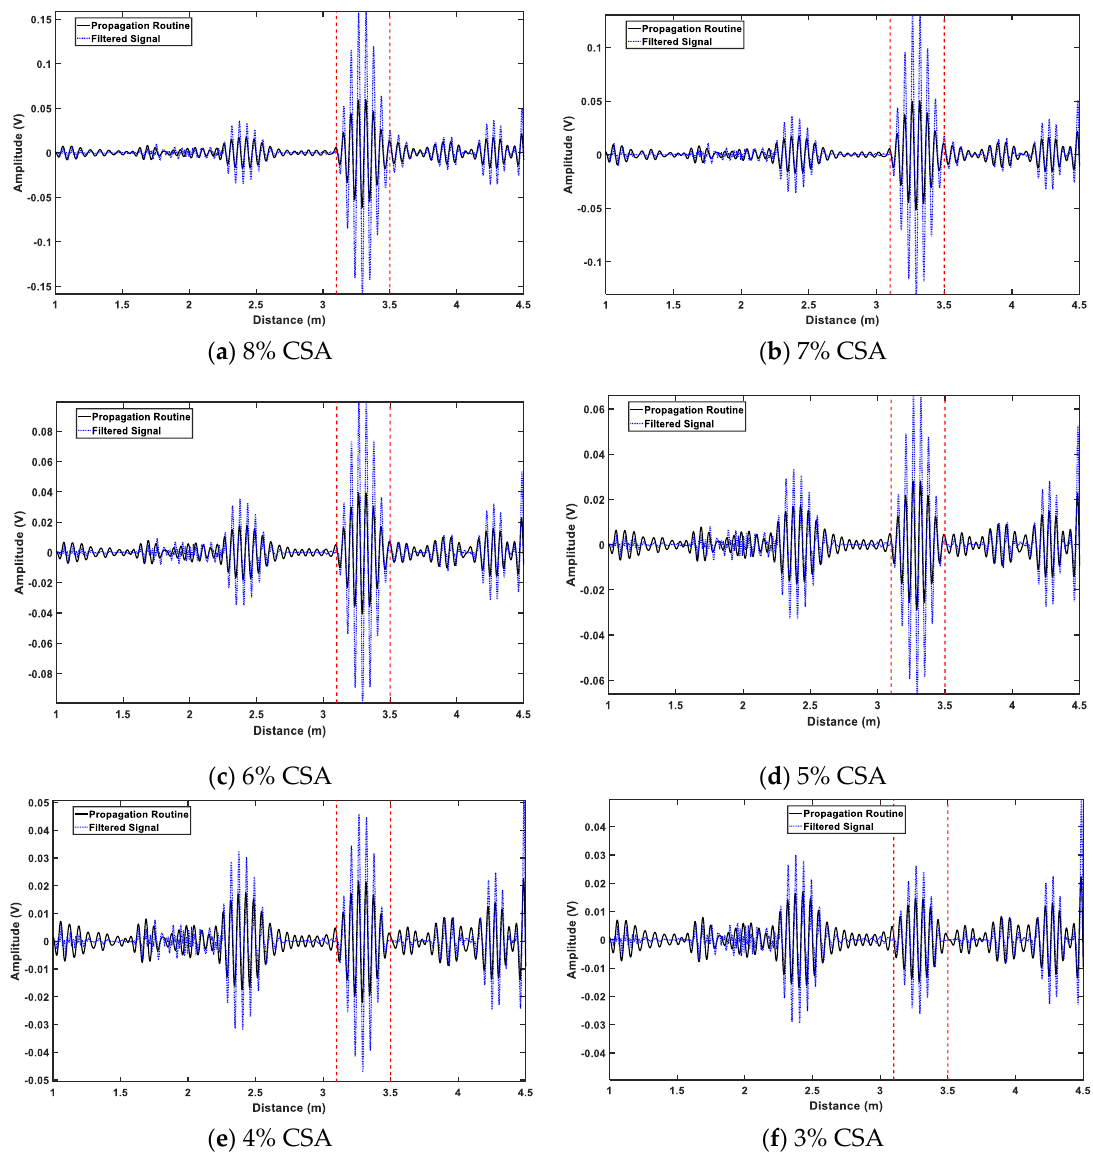
Figure 17. Example of filtered signals using 30 kHz excitation and model parameters where defect size is varying.